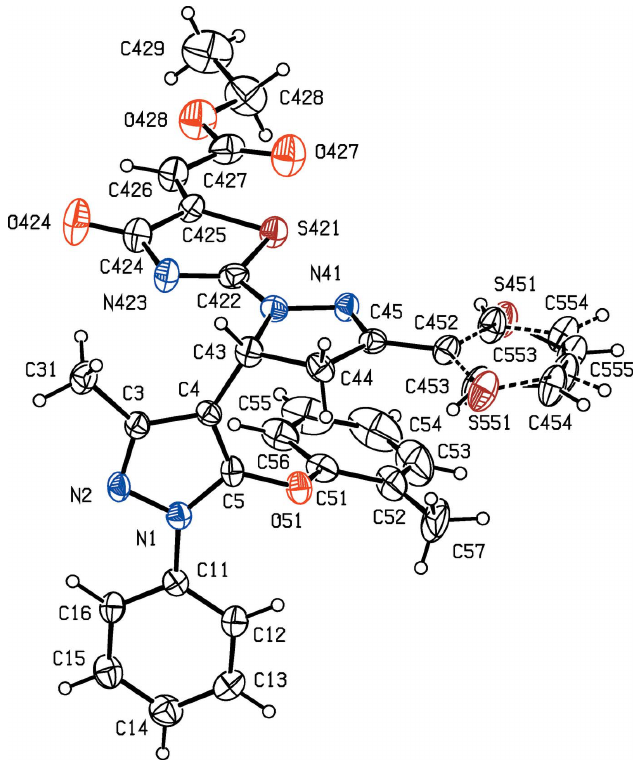
Figure 3 The molecular structure of compound (II) showing the atom-labelling scheme and the disorder in the thiophene unit, where the major disorder component is drawn using full lines and the minor disorder component is drawn using broken lines. Displacement ellipsoids are drawn at the 30% probability level.